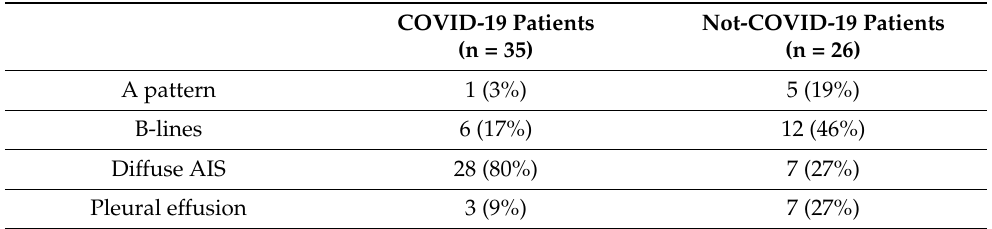
Table 3. LUS findings in the subgroup of patients with respiratory failure. AIS, alveolar-interstitial syndrome. B-lines means focal AIS or B-lines without criteria for diffuse AIS. COVID-19 Patients Not-COVID-19 Patients (n = 35)